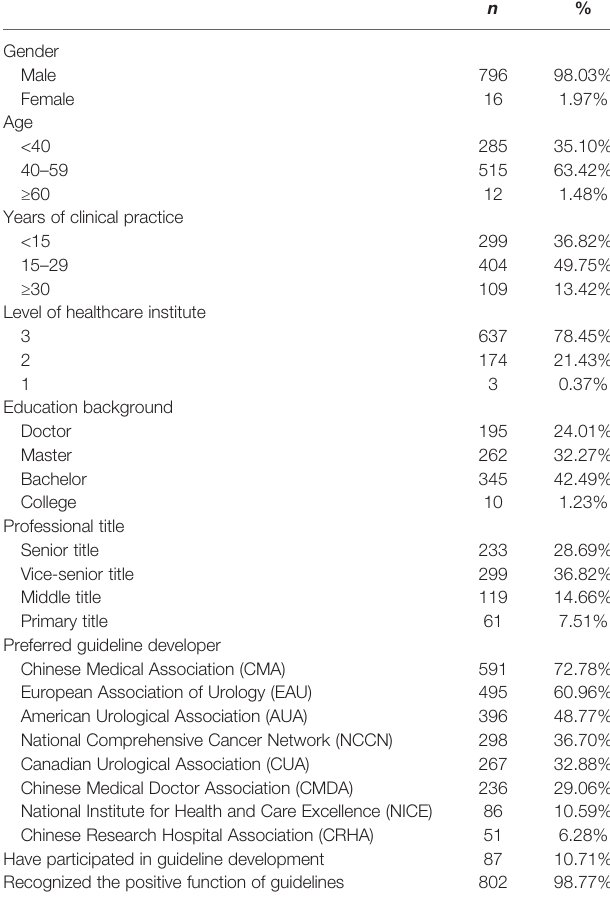
TABLE 1 | Characteristics of the